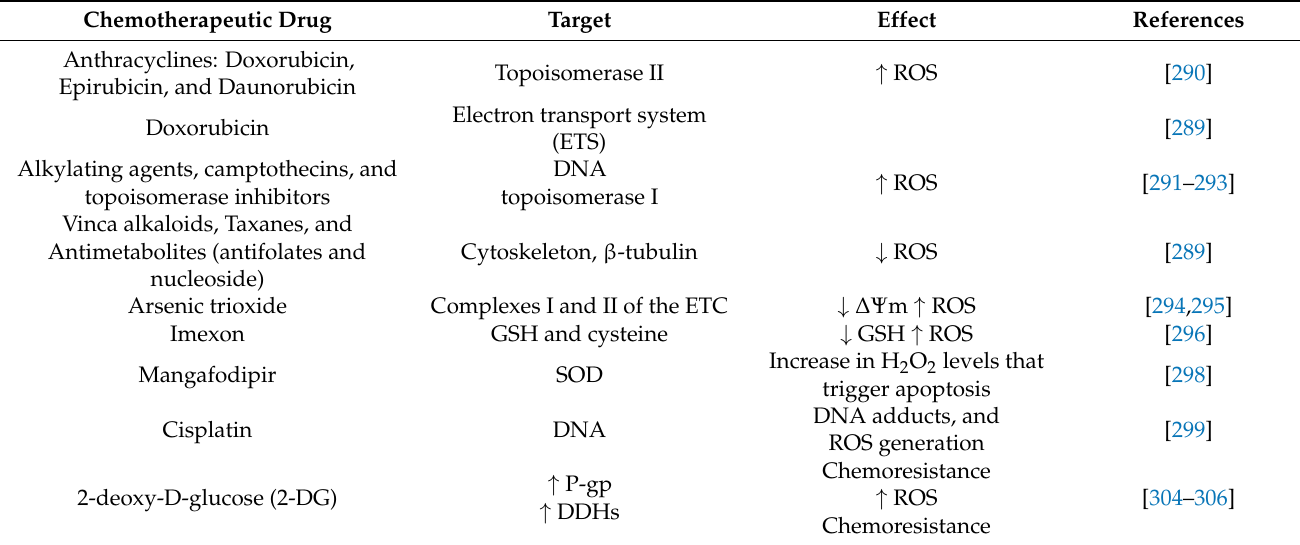
Table 1. Effects and targets of chemotherapeutic drugs on mitochondrial and cellular oxidative